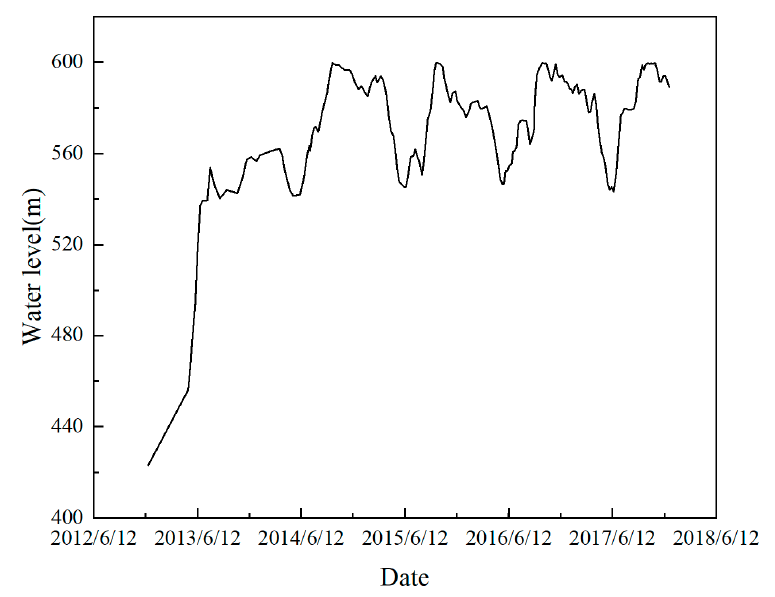
Figure 7. The impoundment process of Xiluodu reservoir. Table 2. Material parameters of bedrock and water.